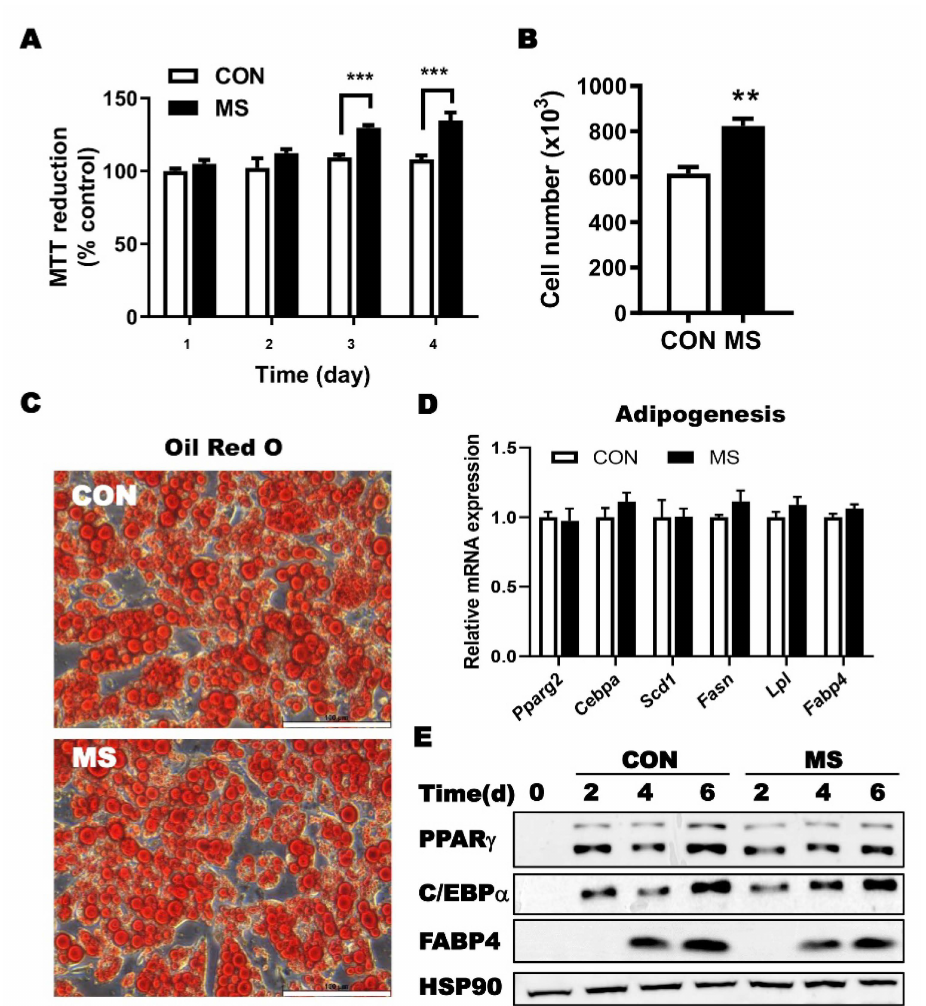
Figure 3. Effects of mechanical stress (MS) on the proliferation and differentiation potential of ASCs. Surgical preconditioning procedures were performed by 25 times needling with 21-gauge needle on the right unilateral inguinal fat pads of mice. SVC were isolated from fat pad at day 5 post-MS or sham procedures and 5 × 10 6 cells were plated, cultured, and followed by in vitro analysis; ( A , B ) MTT reduction and cell number; ( C ) Representative image of Oil Red O staining after adipocyte differentiation of ASCs from MS-treated mice with 40 × magnification; ( D ) Gene expression of adipocyte-specific marker genes. ( E ) Immunoblotting of adipocyte-specific protein, including PPAR γ , C/EBP α , FABP4, and HSP90 as housekeeping protein. Data are means ± SEM ( n = 4). ** p < 0.01; *** p < 0.001 vs.